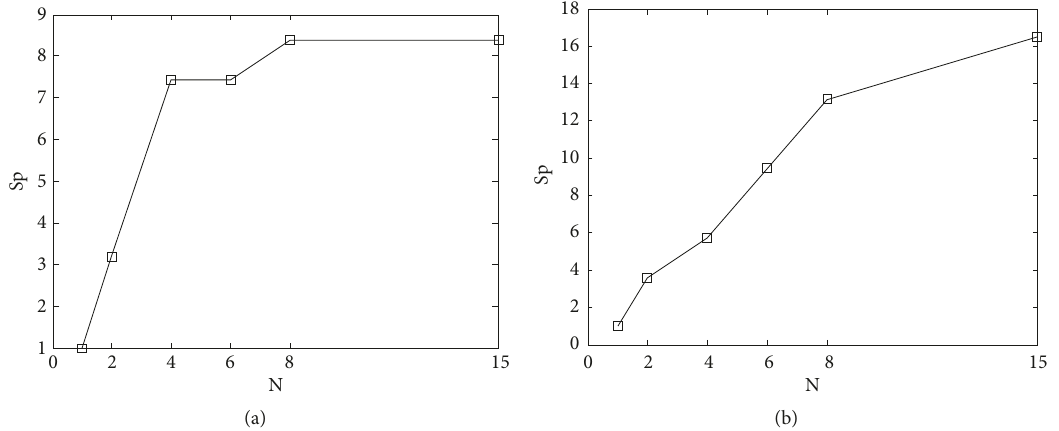
Figure 13: The speedup chart of the Map-Reduce programming model: (a) the ensemble with 8 local NNs; (b) the ensemble with 15 local